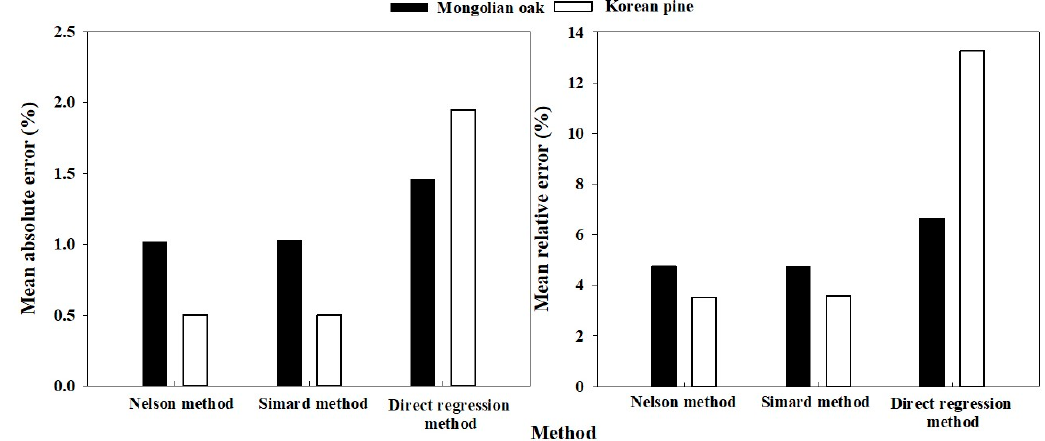
Figure 4. Comparison of litter moisture content model errors for the Mongolian oak and Korean pine.